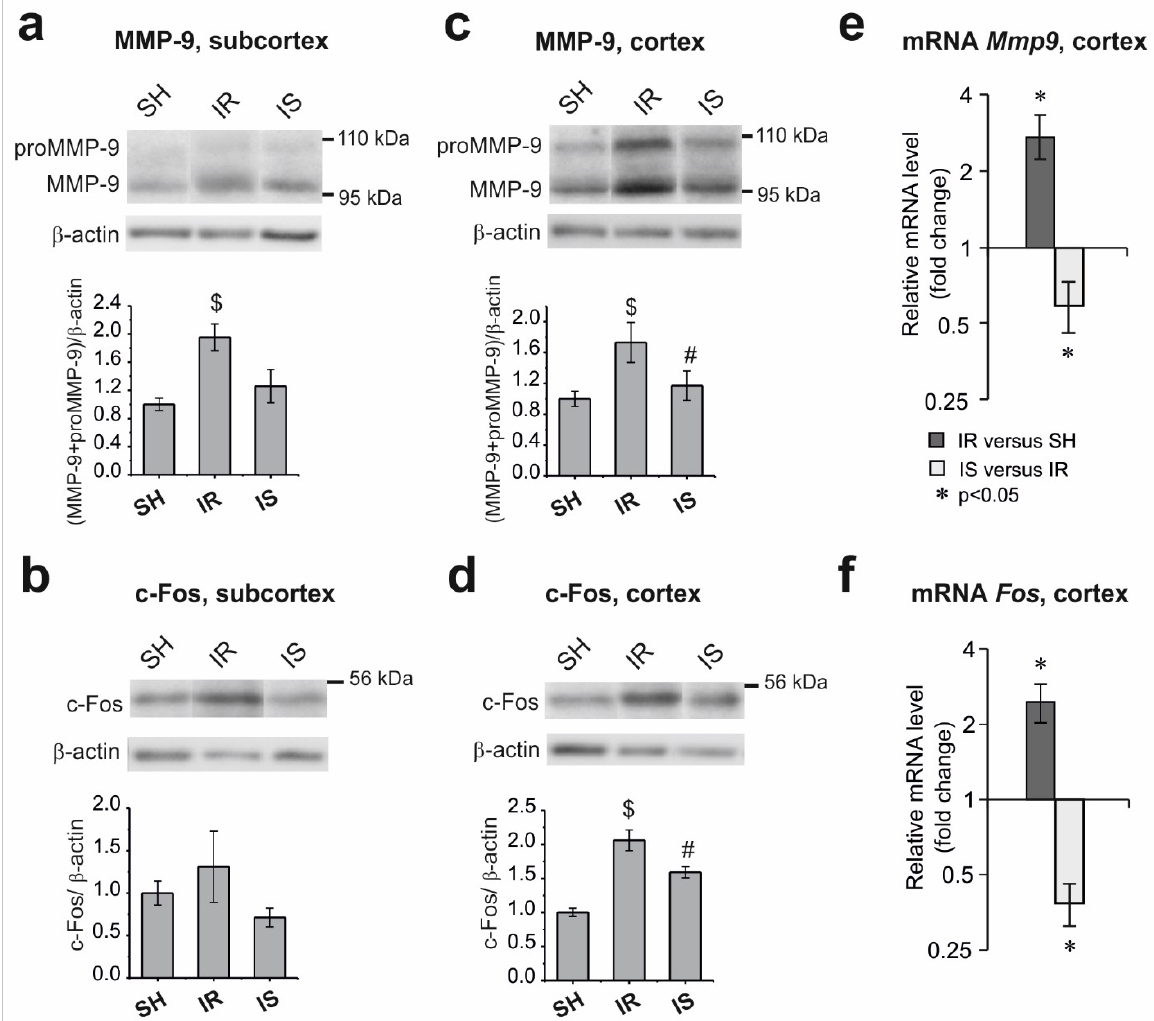
Figure 3. Analysis of the changes in the expression of the MMP-9 and c-Fos proteins, as well as the Mmp9 and Fos mRNA, during ischemia and Semax treatment in rat brain structures at 24 h after tMCAO. Immunoblot analysis of MMP-9 and c-Fos content in the subcortex ( a , b ) and frontoparietal cortex ( c , d ). The upper part of the figures shows a typical immunoblot for each group. The histograms report the relative protein content in the group, which was normalized to that of β -actin; the protein content in the SH group is taken as “1.” The statistical significance is indicated above the bars as *, $ p < 0.05 and # p < 0.05, IR versus SH and IS versus IR, respectively. Changes in the level of the Mmp9 ( e ) and Fos ( f ) mRNA expression in the rat frontoparietal cortex are measured in the IR versus SH and IS versus IR groups. The mRNA level of genes in the groups is normalized to the mRNA level of the Gapdh